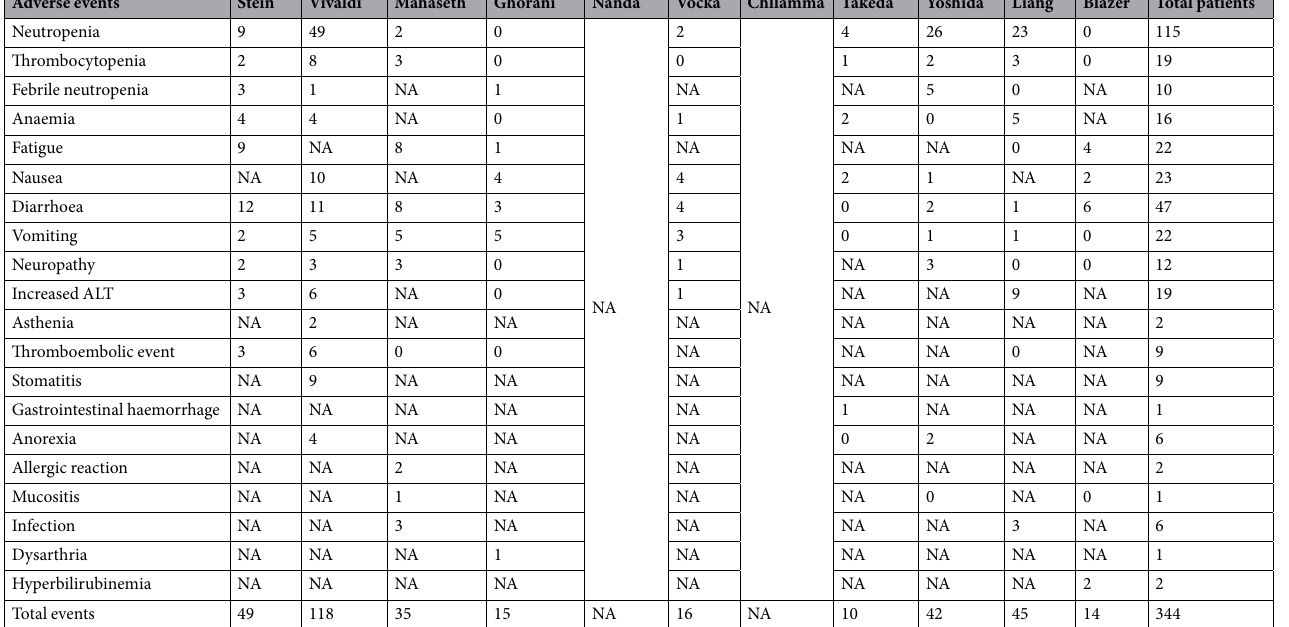
Table 4. The adverse events of modified FOLFIRINOX.